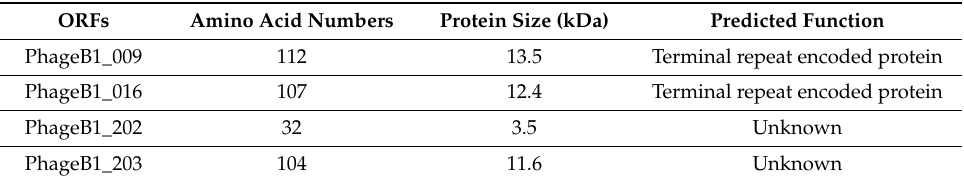
Table 4. List of missing ORFs present in phage B1 but absent in phage JA1.